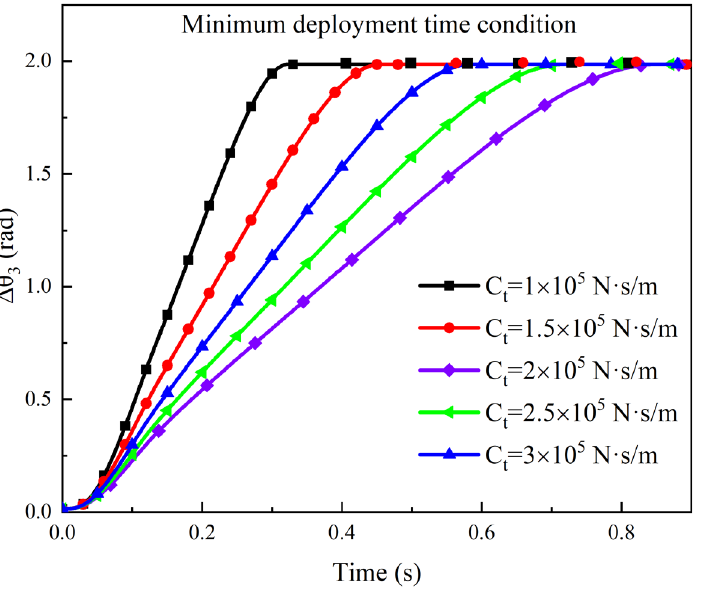
Figure 4. Time history curve of the deployment angle under different C t under minimum Dt con- dition.